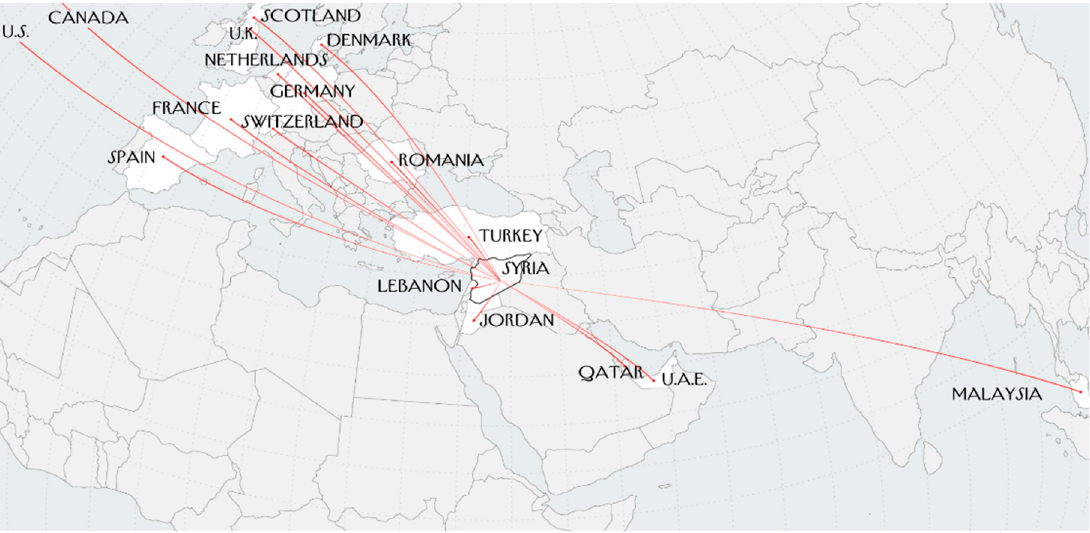
Figure 1. Map following the paths of a hundred artists who have fled Syria since 2011. Source: Griswold (2018), public domain image.